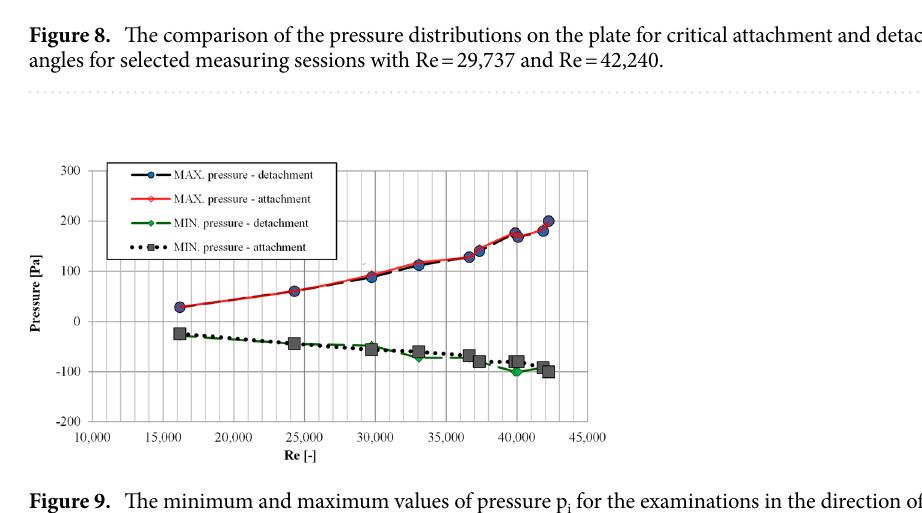
recorded in the examinations in the direction of detachment both in respect of the angle of the plate inclination and the pressure values. It can be noticed that for the discussed minimum and maximum pressure values that were recorded in the examinations in the direction of detachment or in the direction of attachment, not only the values for the angle of the plate inclination that they were recorded at in particular sessions are in accordance. Their values within particular measuring sessions are also convergent. For a study with a defined value of the Reynolds number, the maximum and minimum pressure values recorded in the examinations in the direction of on detachment are in accordance with the values recorded in the examinations in the direction of the jet reattachment (Fig. 9). The analysis of the maximum and minimum recorded p i pressure values makes it possible to notice that an increase of the Reynolds numbers results in an increase of the deviation from zero for the minimum and maximum pressure values recorded in the examinations in the direction of detachment or in the direction of attachment. As for the study characterized by the highest Reynolds number (Re = 42,240), the difference between the maximum and minimum pressure value recorded for the whole study was about 300 Pa. In the case of the study with Re = 16,192, that difference was only about 52 Pa.